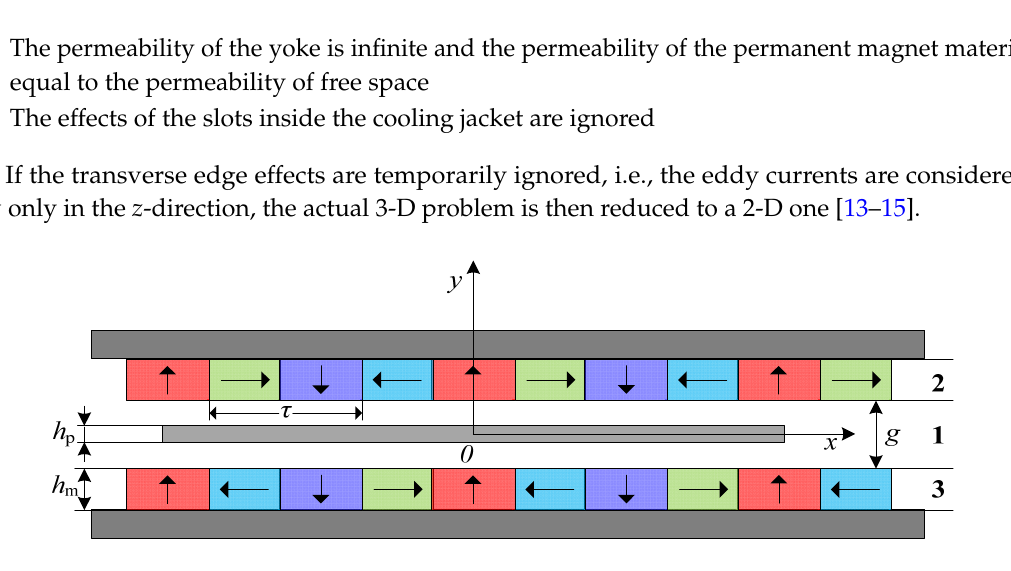
Figure 2. The analytical model of the permanent magnet linear synchronous motors (PMLSM).